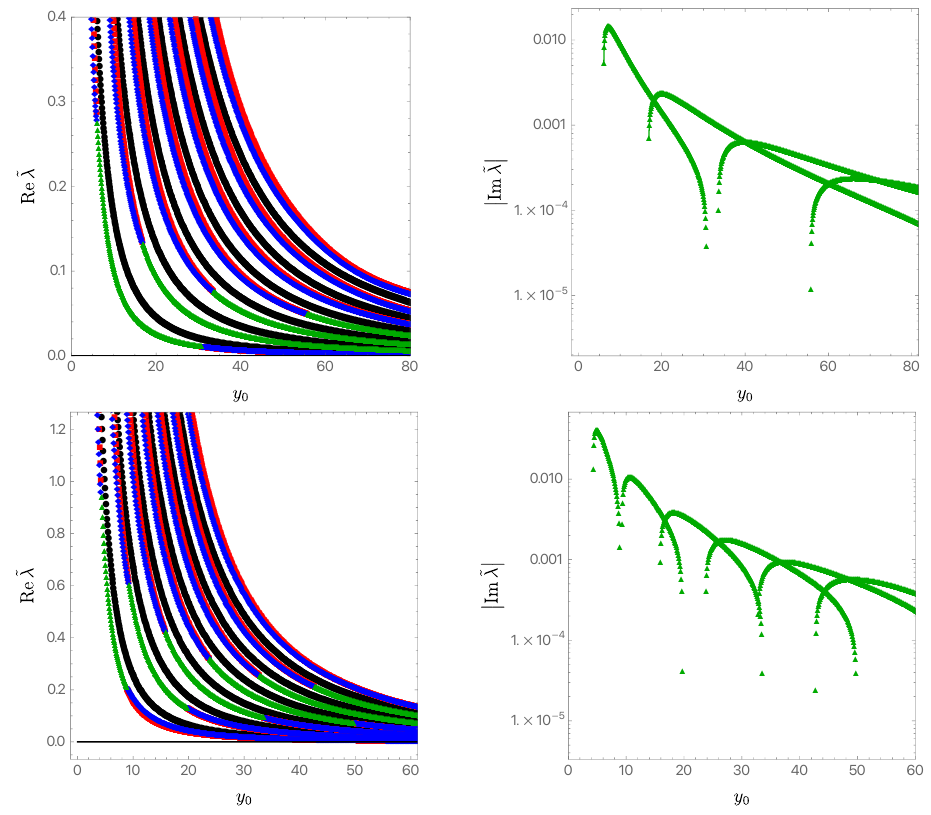
Figure 3 . The real part (left column) and the absolute value of the imaginary part (right column) of the excited modes as a function of y 0 and y + = 0 . The top row has d = 4 , while the bottom row has d = 5 . The colour coding is as follows: green triangles are non-gauge modes with complex eigenvalues; blue diamonds are non-gauge modes with negative norm under ˆ G ; red squares are non- gauge modes with positive norm under ˆ G and the black disks are pure gauge modes. The plot on the right panel is presented in a logarithmic scale, and each green triangle has a two-fold degeneracy since complex modes come in conjugate